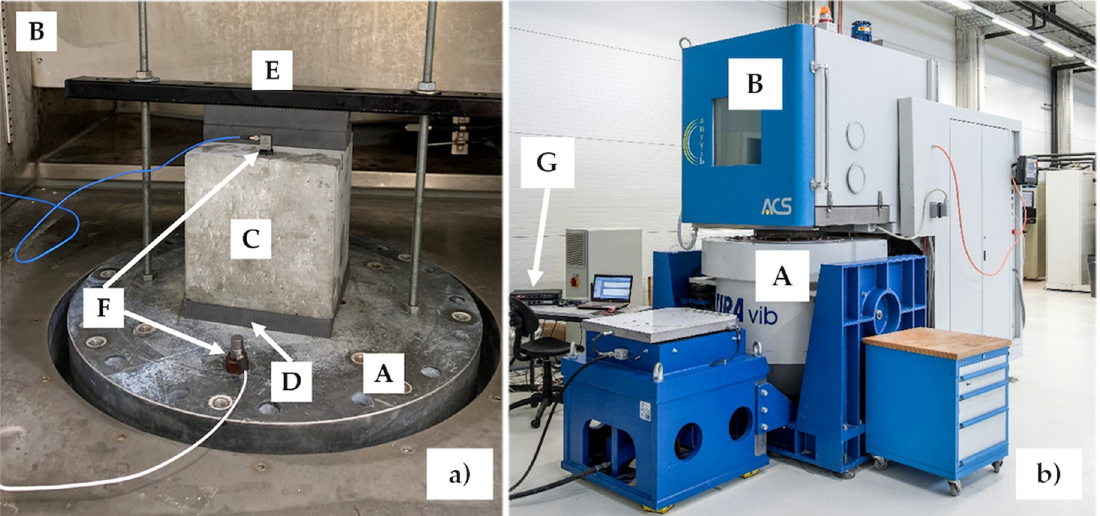
Figure 5. ( a ) The measurement system used in this study (inner view): (A) vibration system, (B) climate chamber, (C) concrete block, (D) test specimen, (E) fixtures, and (F) acceleration sensors. ( b ) The measurement system used in this study (outer view): (A) vibration system, (B) climate chamber, (G) vibration testing controller and acquisition system.